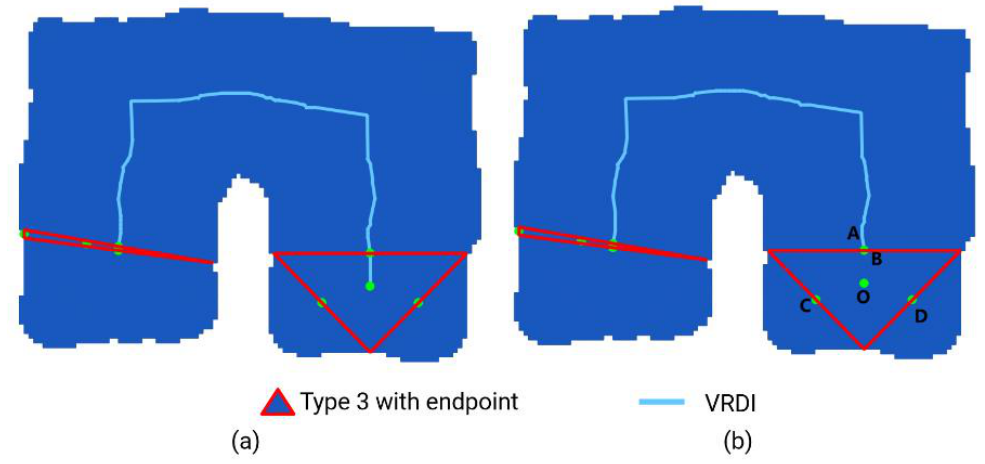
Figure 13. Triangle with endpoints. ( a ) C-shaped building with endpoint; ( b ) Result of VRDI method for endpoint.